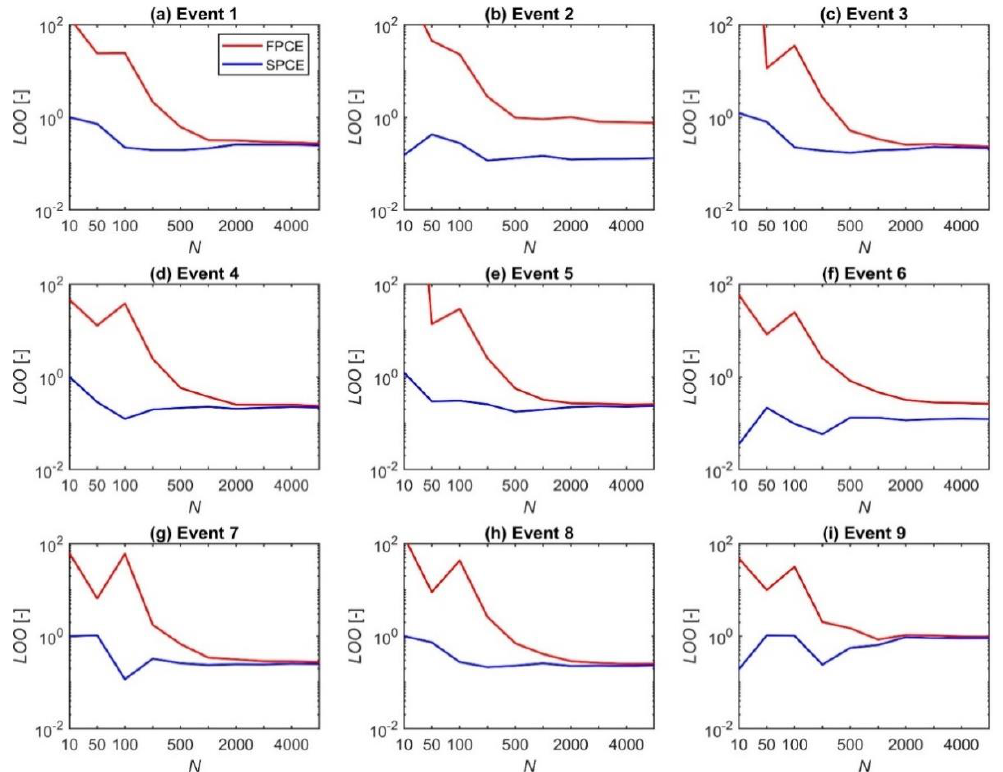
Figure 3. The effects of the size of experimental design ( 𝑁 ) on the leave-one-out cross-validation error ( 𝐿𝑂𝑂 ) in constructing surrogate models using FPCE and SPCE for nine streamflow events.